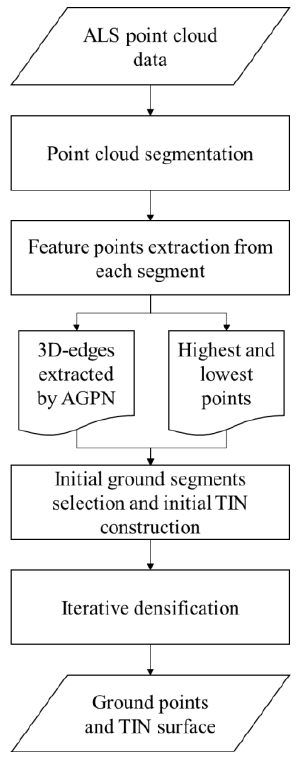
Figure 4. The improved ALS point cloud filtering method.